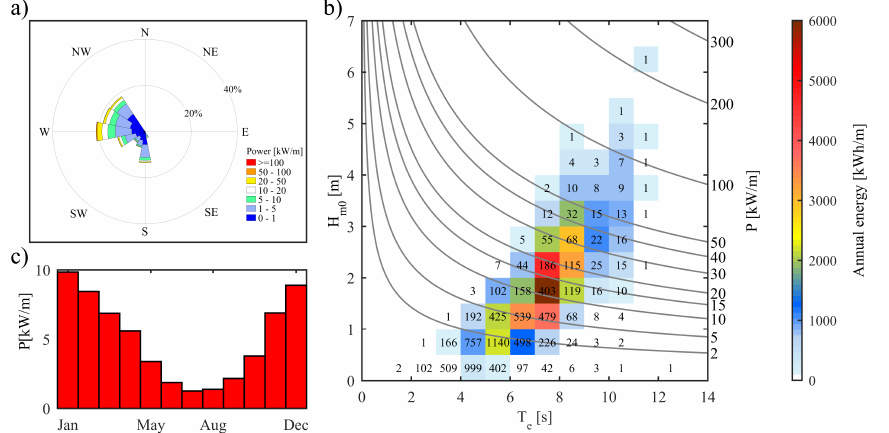
Figure 17. Characterisation of mean yearly wave energy and wave energy flux climate at point HT4; ( a ) the wave energy flux rose; ( b ) the scatter plot of H m e T e , the colour scale indicates annual energy 0 per meter of wave front (kWh/m), the numbers within the bins indicate the occurrence of sea states (hours/year) and the isolines specify the wave energy flux; ( c ) the histograms of the monthly mean wave energy